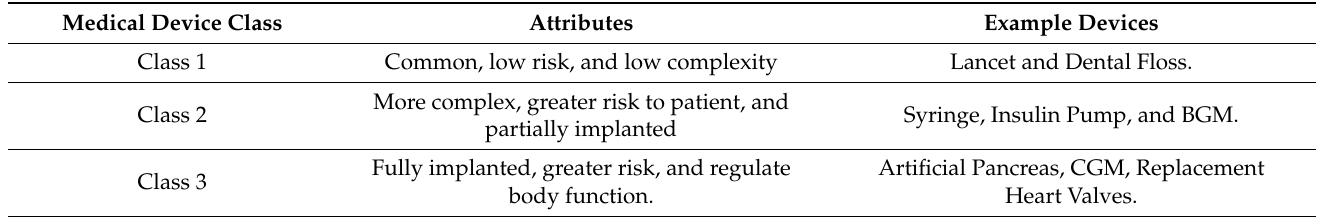
Table 6. The medical device classes [71]. Abbreviations used: BGM, Blood Glucose Meters; and CGM, Continuous Glucose Monitoring. Reprinted with permission from Ref. [71]. 2017 Institute of Electrical and Electronics Engineers.